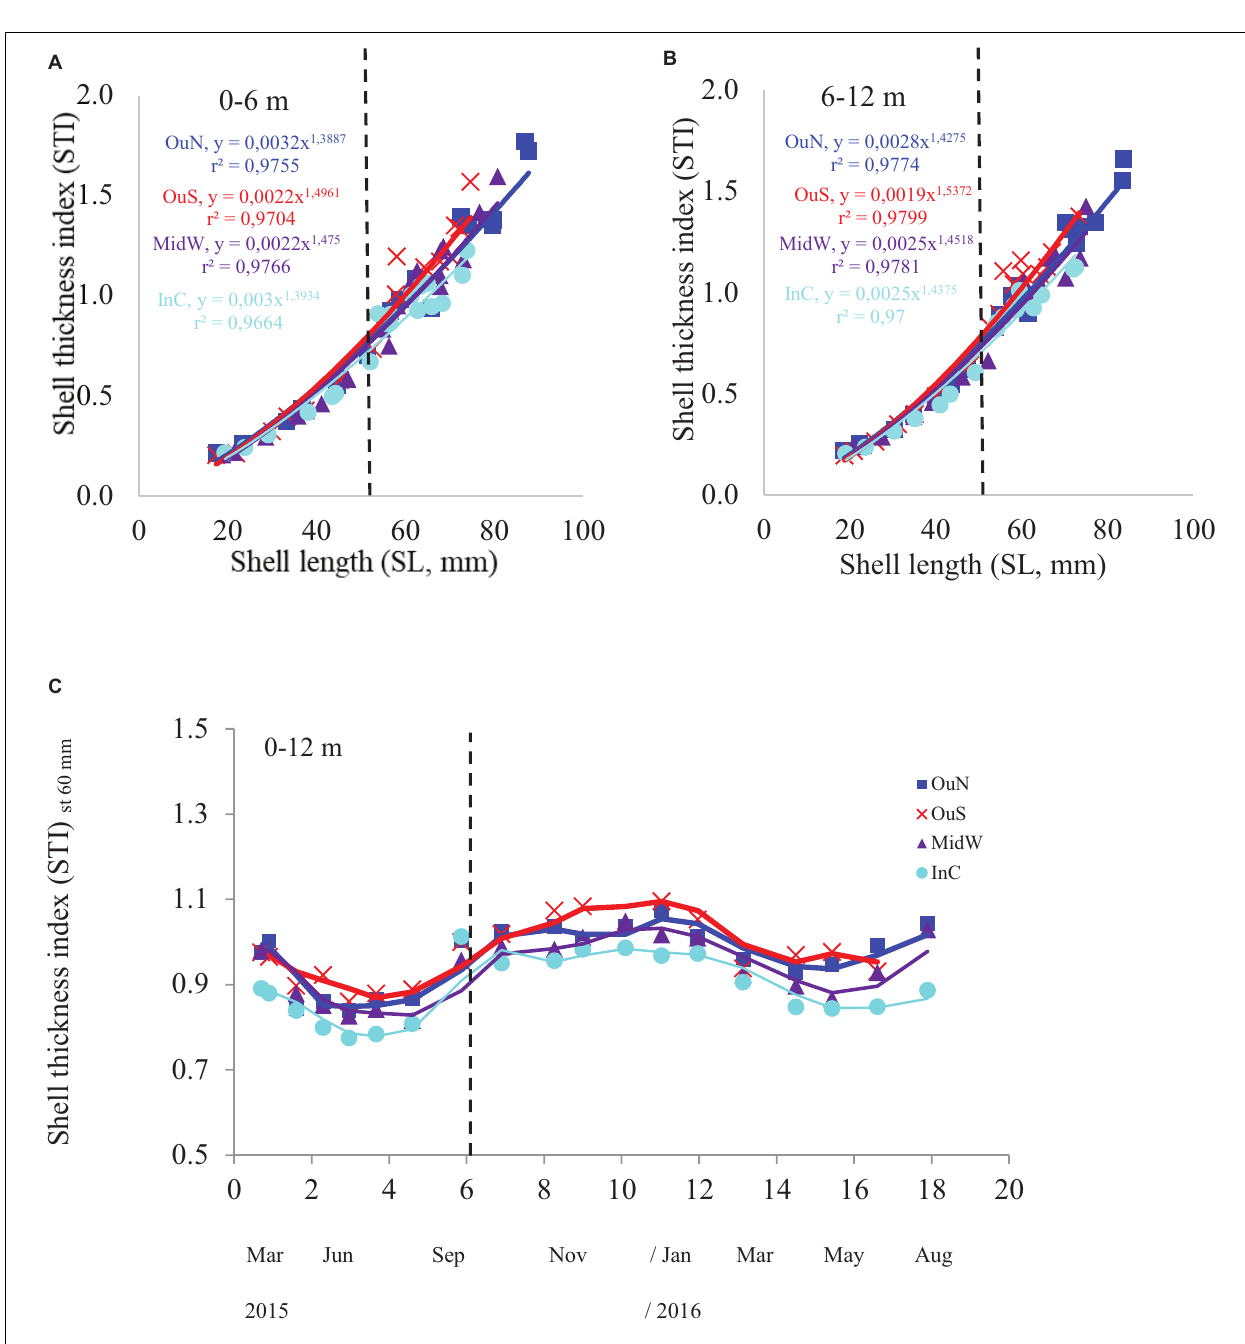
values at the end of the experiment were still lower than those observed at 8 months ( Figure 7 ). For the innermost sites, MidW and InC, the PROFIT values were highest (14– 18%) at the end of the experimental period (18 months) ( Figure 7 ), revealing a clear difference between outer and inner estuarine